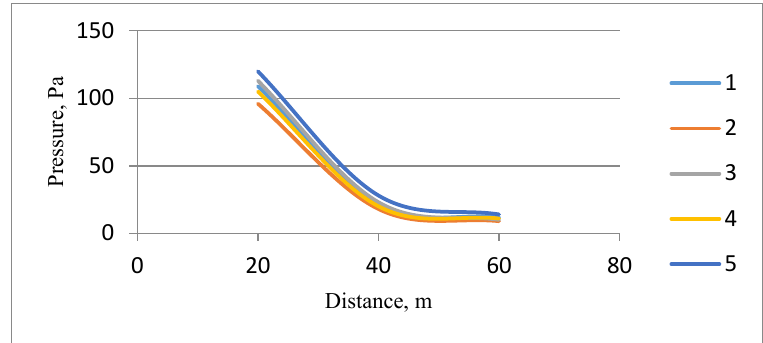
Fig.8. Curves of pressure dependence on